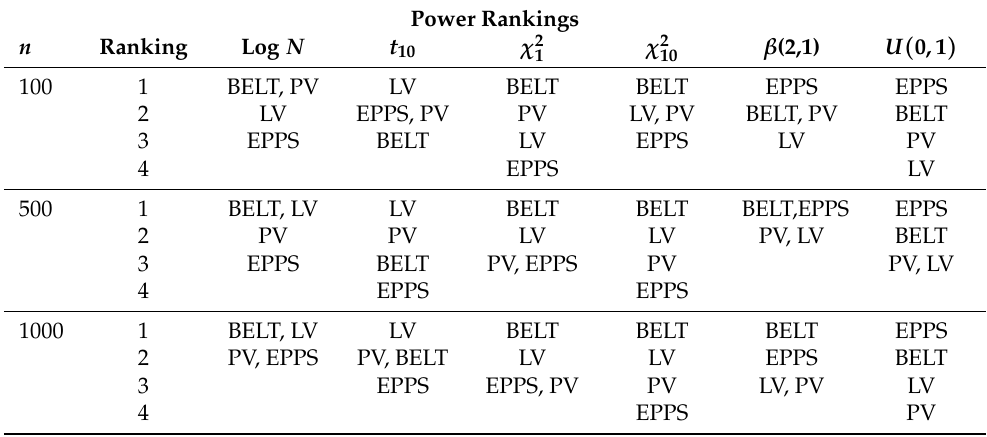
Table 7. Ranking of tests using average powers computed from the empirical rejection probabilities in Tables 4–6 for n = 100, 500 and 1000.